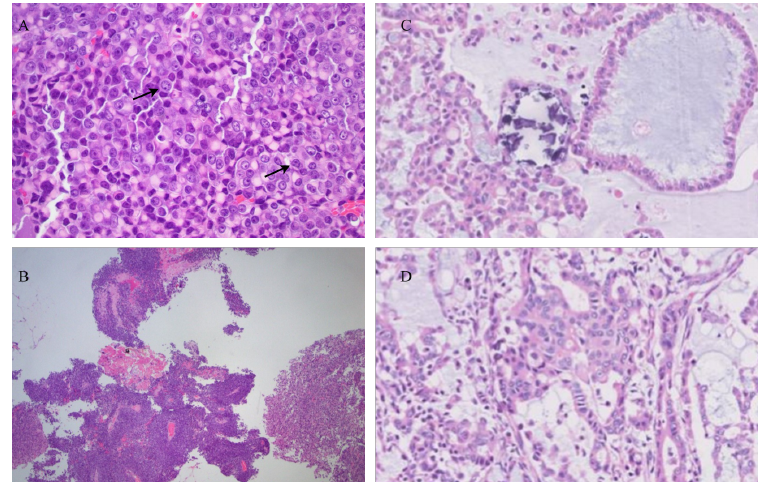
Figure 3. Histopathologic findings of rhabdoid pancreatic carcinoma showing the pleomorphic type of rhabdoid carcinoma with rhabdoid inclusions (black arrows). Monomorphic type of rhabdoid pancreatic carcinoma with rhabdoid inclusions. ( A ) HE stain at 400×; ( B ) HE stain at 40×; ( C , D ) HE stain at